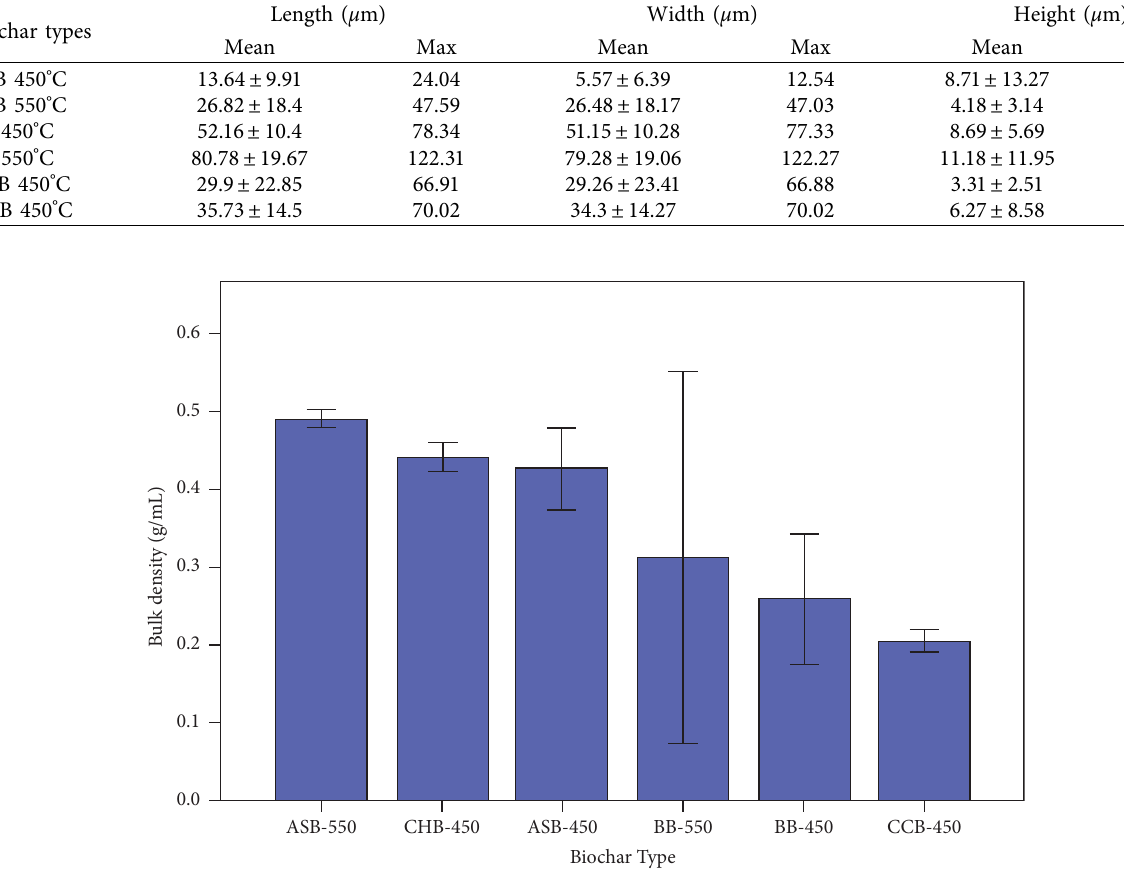
Figure 4: Bulk density of biochars.